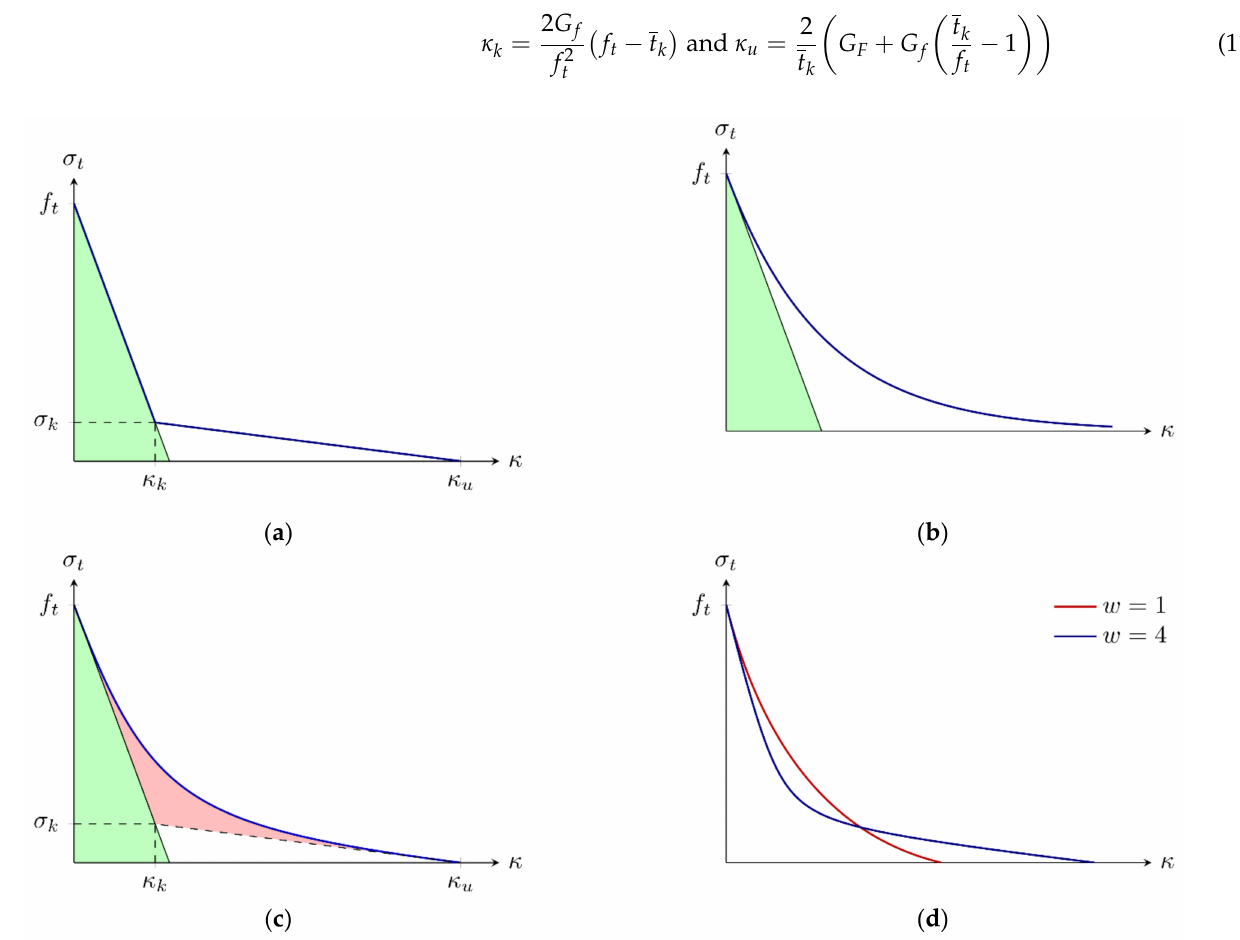
Figure 3. Softening curves: ( a ) bilinear; ( b ) exponential; ( c , d ) rational Bezier. Using the total fracture energy G F and the initial fracture energy G f (area under the initial tangent line from the peak point at Figure 3, marked as a green area). The equivalent relationship (in a continuum format) was used by Hoover and Bažant